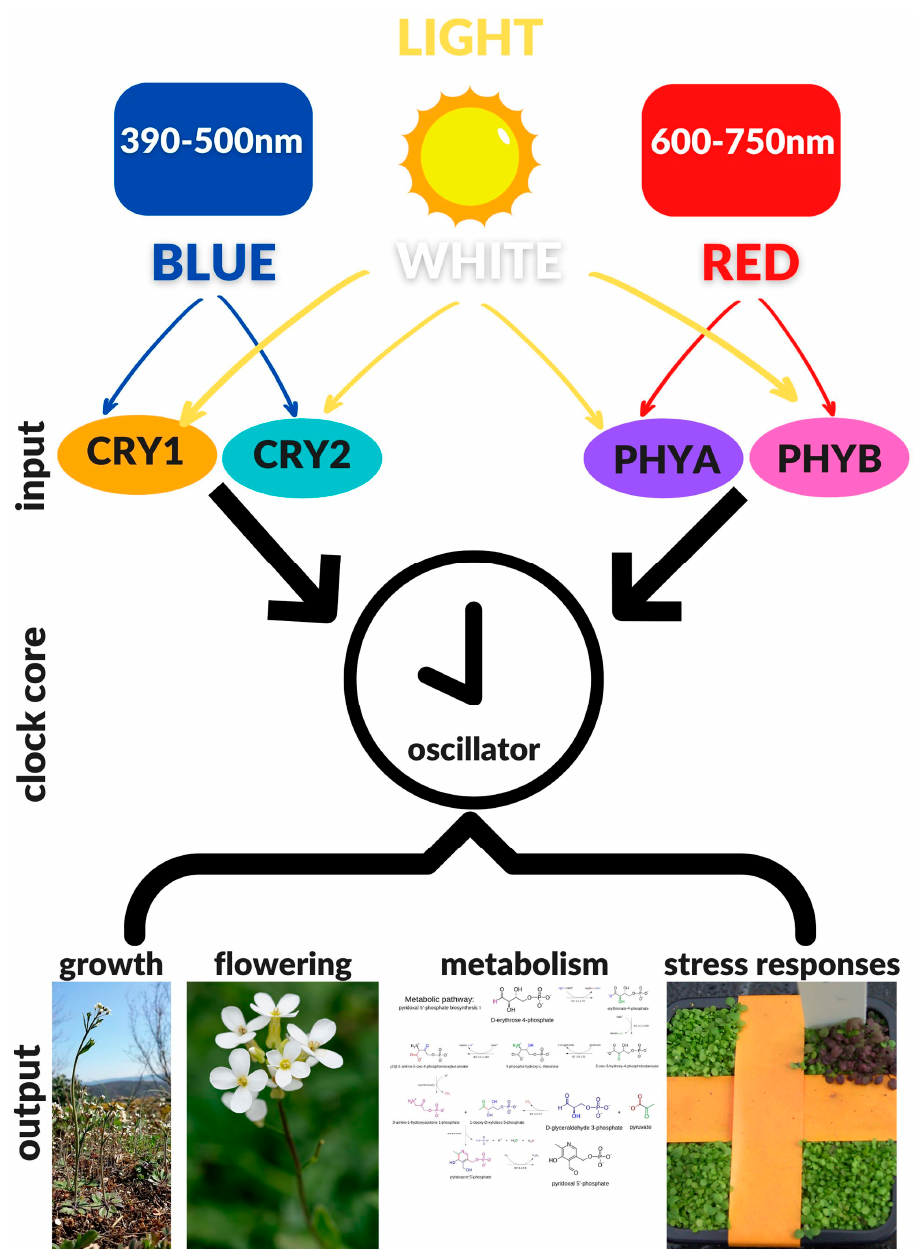
Figure 1. Schematic representation of the Arabidopsis circadian clock, depicting the three principal components of the circadian machinery: The INPUT system—cryptochromes (CRYs) and phytochromes (PHYs)—that receives light stimuli and entrains the clock; the CLOCK CORE that generates 24-h self-sustained oscillations, also in absence of environmental stimuli; the OUTPUT system that adapts the developmental and physiological responses of the plant to the circadian fluctuations. Images from: